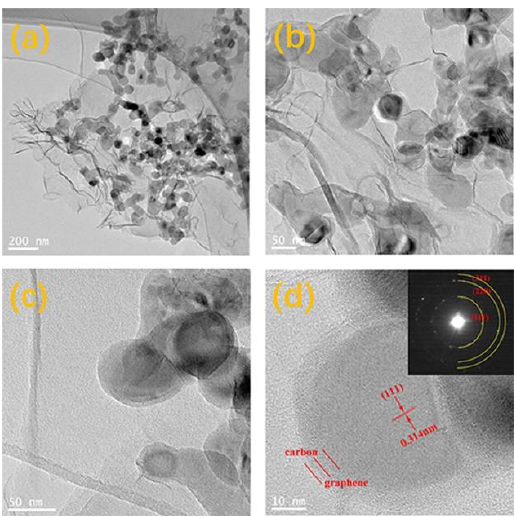
Figure 5. ( a – d ) Transmission electron microscope (TEM) images of C@Si/rGO film under different magnification and the selected electron diffraction (SEAD) pattern of Si as inserted in Figure 5d.